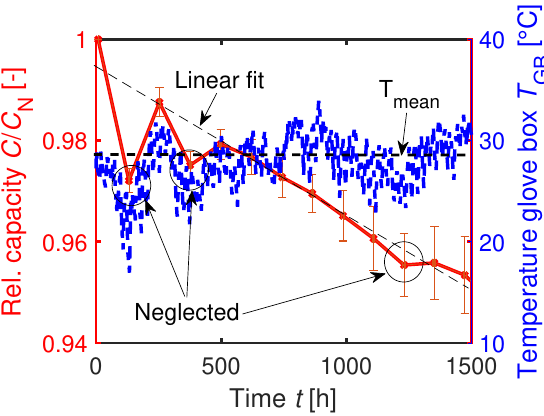
Figure A1. Temperature-dependent capacitance measurement at room temperature inside the glove box. Allocation of capacity outliers due to a lower ambient